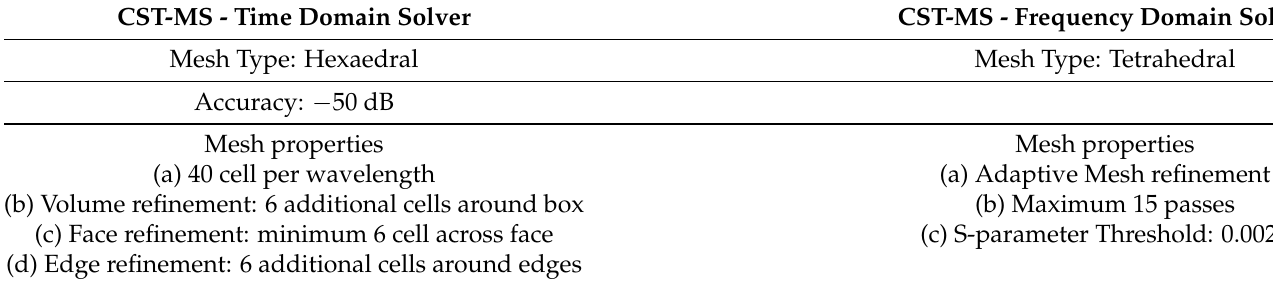
Table A1. Simulation settings in CST Microwave